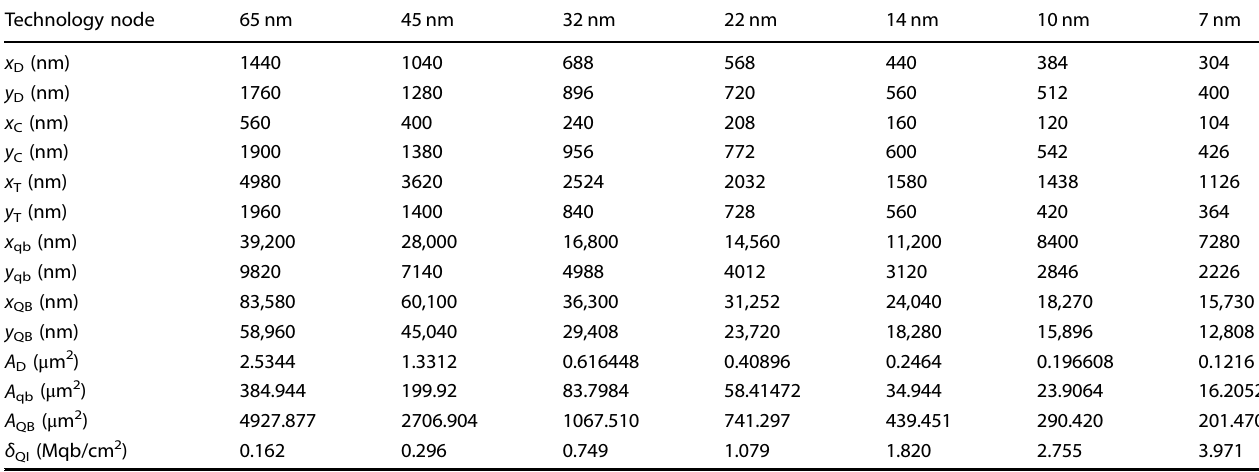
Table 3. Size ( x and y ) of all the base (D,C,T) and composed (qubit qb and qubyte QB ) devices, area A of the D module, of the logical qubit and of the qubyte, and density of quantum information δ QI Technology